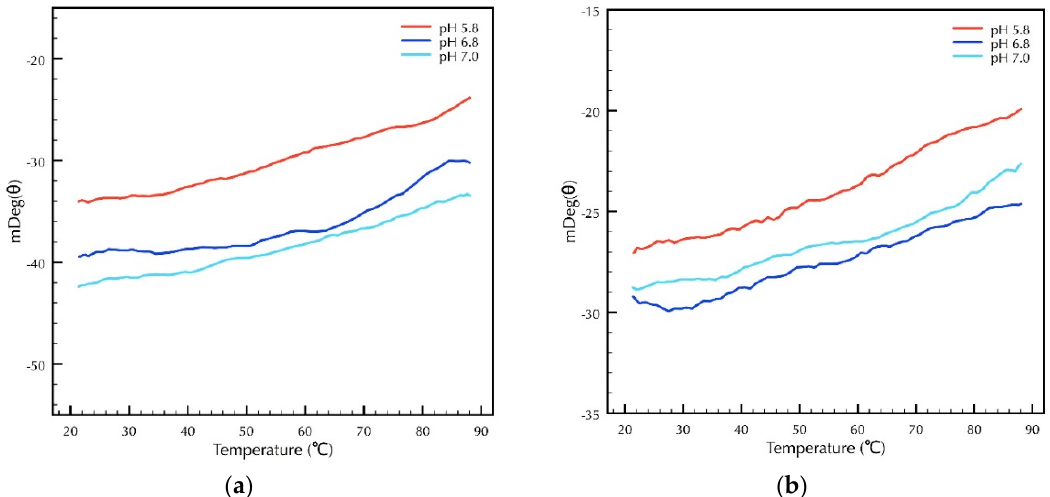
Figure 5. Thermal denaturation studies of CRPs under different pH conditions reveal proteins with high thermal stability. The millidegrees measured at 208 nm was monitored continuously in the temperature range from 20 to 90 °C by CD. Recombinant proteins were buffered at different pH of 5.8, 6.8, and 7.0. ( a ) CRP1; ( b ) CRP4.